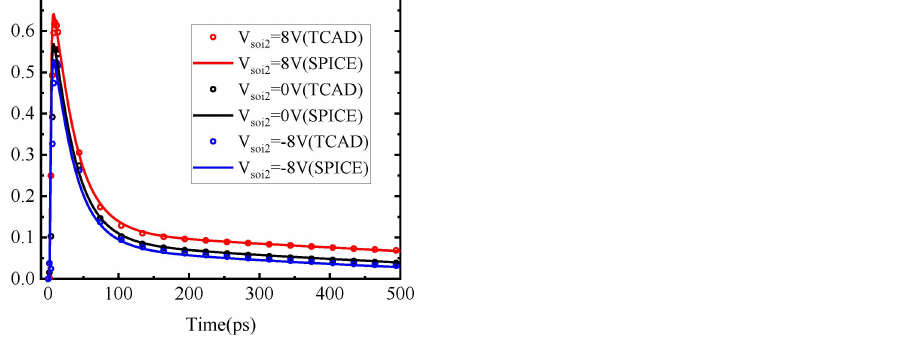
Figure 13. Bipolar amplification current with different back-gate voltages of TCAD simulation and SPICE